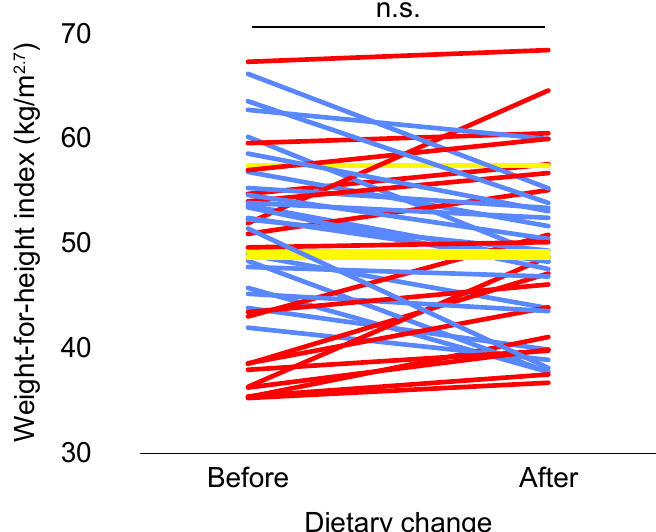
Figure 1. Effect of dietary change on weight-for-height index (WHI) in adult female long-tailed macaques. Each line represents an individual ( n = 44). Blue lines represent a decrease, while red lines indicate an increase and yellow lines represent no change. n.s. means non-significant ( p ≥ 0.05).